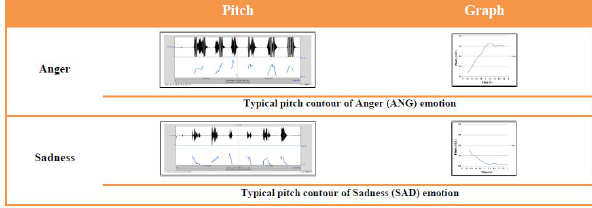
Fig. 7. Asian pitch contours for Anger and